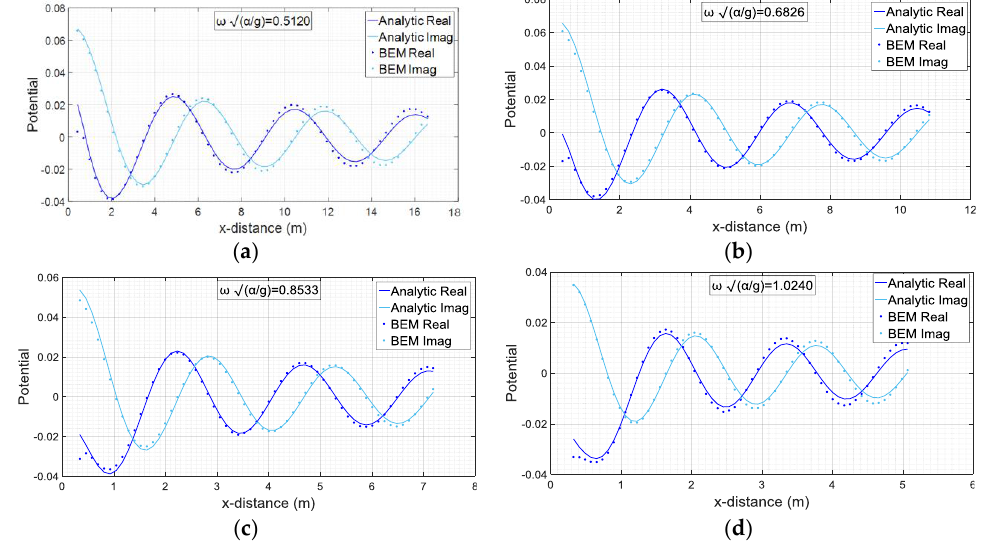
Figure 3. Comparison of present BEM results with the analytic solution in case of cylindrical WEC a/h = 1/3.5 and d/a = 1.5, where α: radius, h: local depth and d: draft, for different values of the non-dimensional frequency / a g : ( a ) 0.5120; ( b ) 0.6826; ( c ) 0.8533; ( d ) 1.0240.